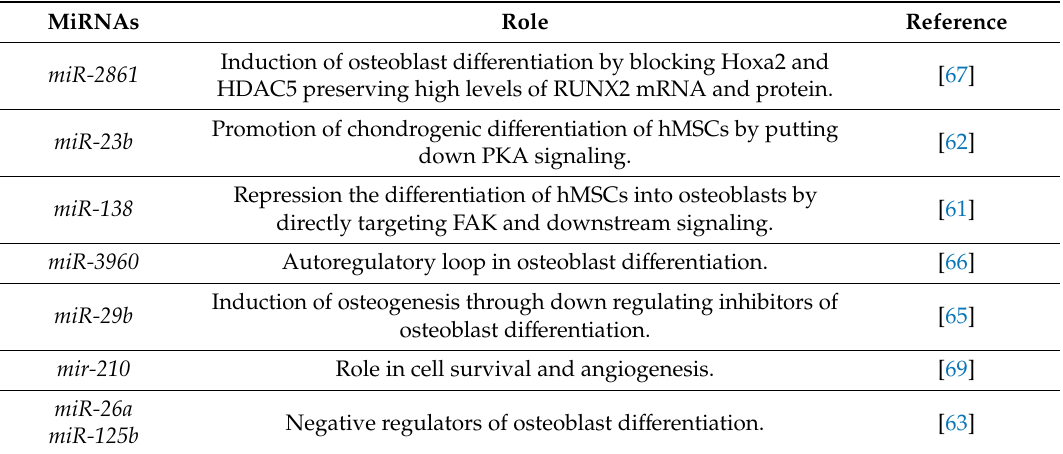
Table 1. MicroRNAs role in the osteogenesis and